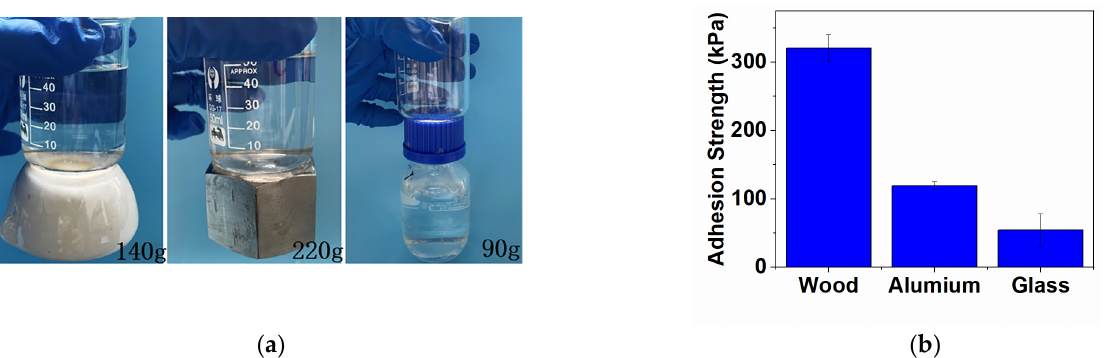
Figure 5. ( a ) Surface adaptability of DACS hydrogels: ceramic, metal, and plastic; ( b ) Average adhesion strength on wood, metal, and glass.